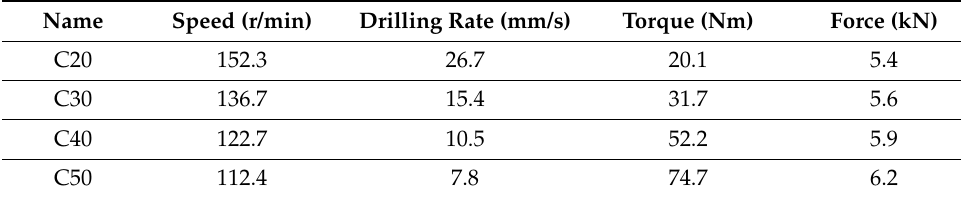
Table 3. Bit input and output average parameters.